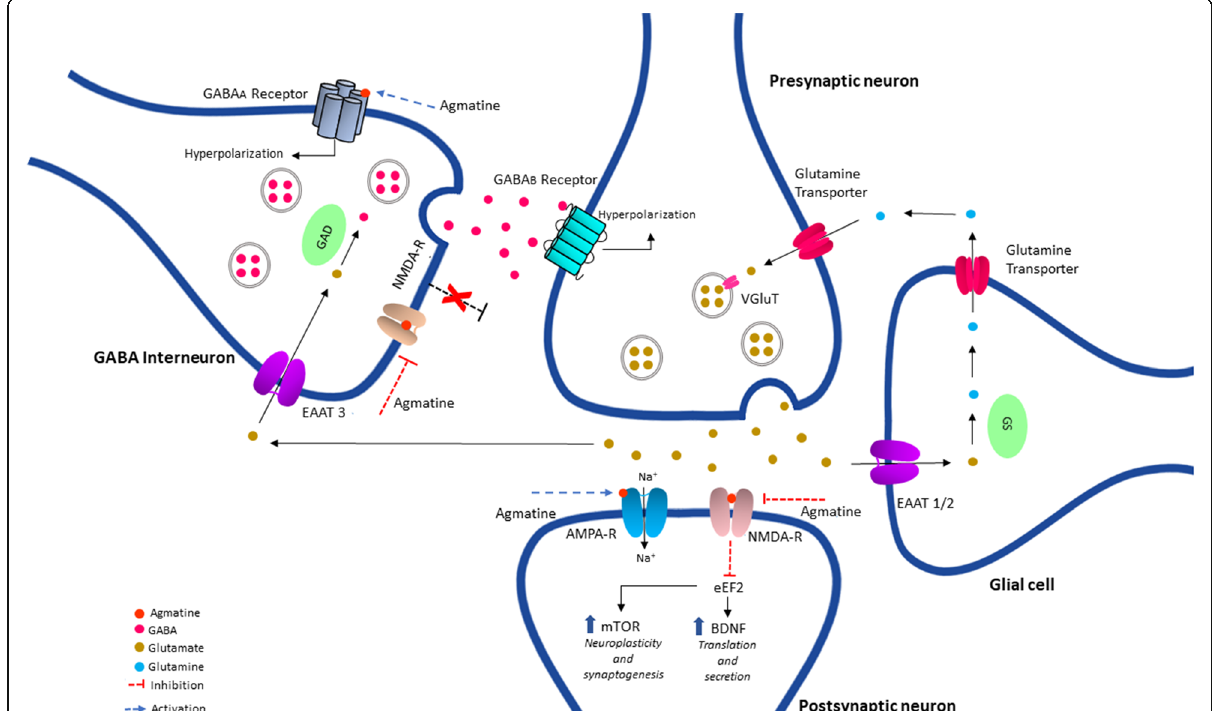
Fig. 1 Potential mechanism of action of agmatine against withdrawal syndrome. Agmatine may block NMDA (N-methyl-D-aspartate) receptor found on GABAergic interneurons. This leads to dis-inhibition of GABAergic interneurons and increases the firing activity in pyramidal cells that induces glutamate release. Consequently, extracellular glutamate increases and activates AMPA receptor that stimulates mTOR pathway. Agmatine may also inhibit NMDA receptor on post glutamatergic neuron. This leads to reduction in eEF2 (eukaryotic elongation factor 2) phosphorylation that de- suppresses translation of BDNF. Glutamate is transferred to GABA interneuron by EAAT3 (excitatory amino acid transporter) and to Glial neuron by EAAT1/2 transporters. GABA is produced from glutamate by the action of enzyme GAD (glutamic acid decarboxylase). Glutamate is converted in glutamine by GS (glutamine synthetase). GABA B receptor is activated by binding of GABA that causes hyperpolarization of neuron hence limiting release of glutamate. Extracellular levels of glutamate are reduced by glial cells by transforming into glutamine. Glutamine is stocked until necessary and transported into presynaptic neuron by glutamine transporter. Glutamate is then stocked into presynaptic neuron by VGluT (vesicular glutamate transporters). Agmatine may also bind to GABA A receptor that leads to the hyperpolarization of